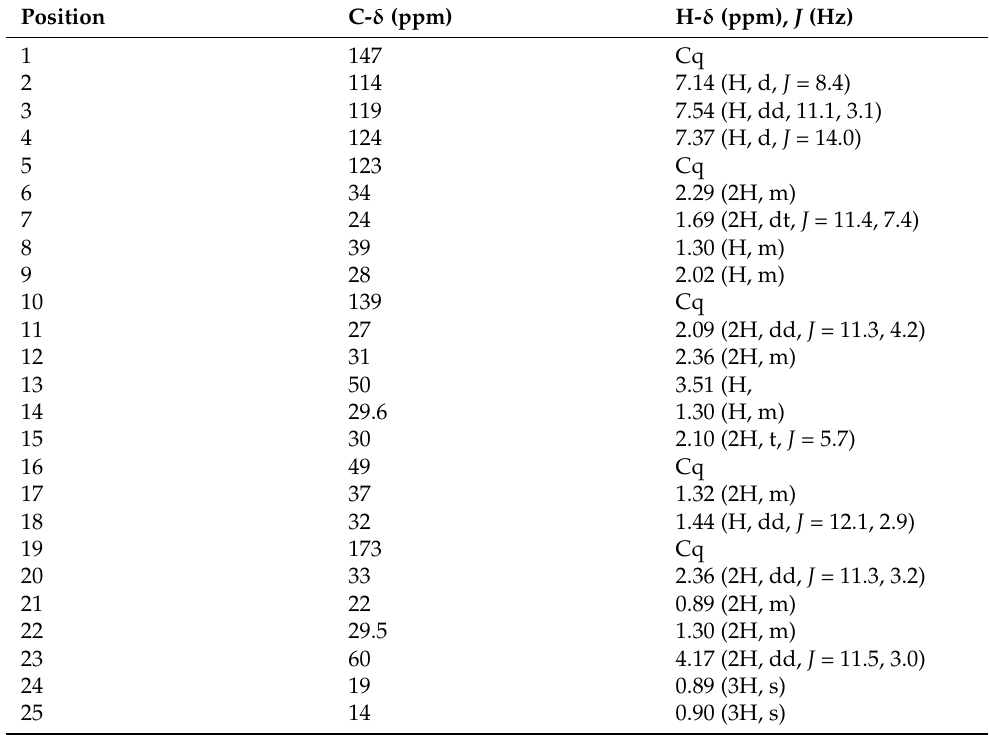
Table 1. Proton and carbon-13 signals and the multiplicity of